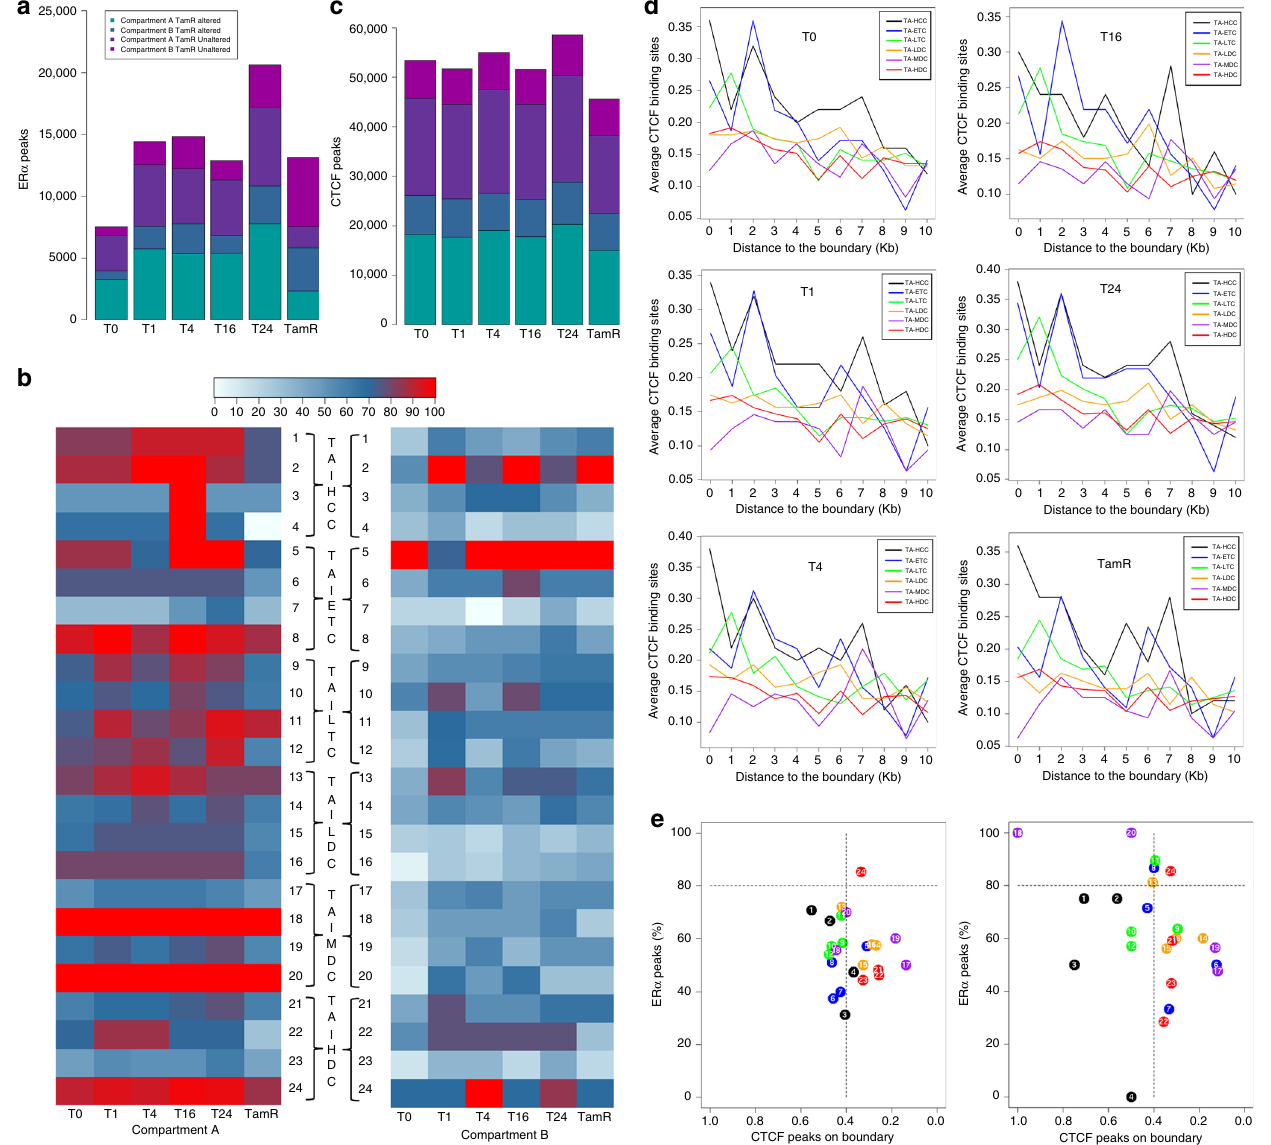
Fig. 5 A distribution of ER α and CTCF peaks in E2-induced TDRCs and TRACs. a The number of ER α peaks. b Heatmap showing the percentage of altered TamR compartments A (Left) and B (Right) with ER α peaks. c The number of CTCF peaks. The legend is the same as ( a ). d The average of CTCF peaks on altered TamR compartment boundary in E2-induced fi ve time points and TamR MCF cell lines. e The distribution of each of 24 patterns (circled) of ER α peaks within compartments and CTCF peaks on compartment boundary in E2-induced MCF7 cells (left) and in TamR cells (right). CTCF CCCTC-binding factor, TDRC temporally dynamic re-compartmentalization, TRAC tamoxifen-resistant altered